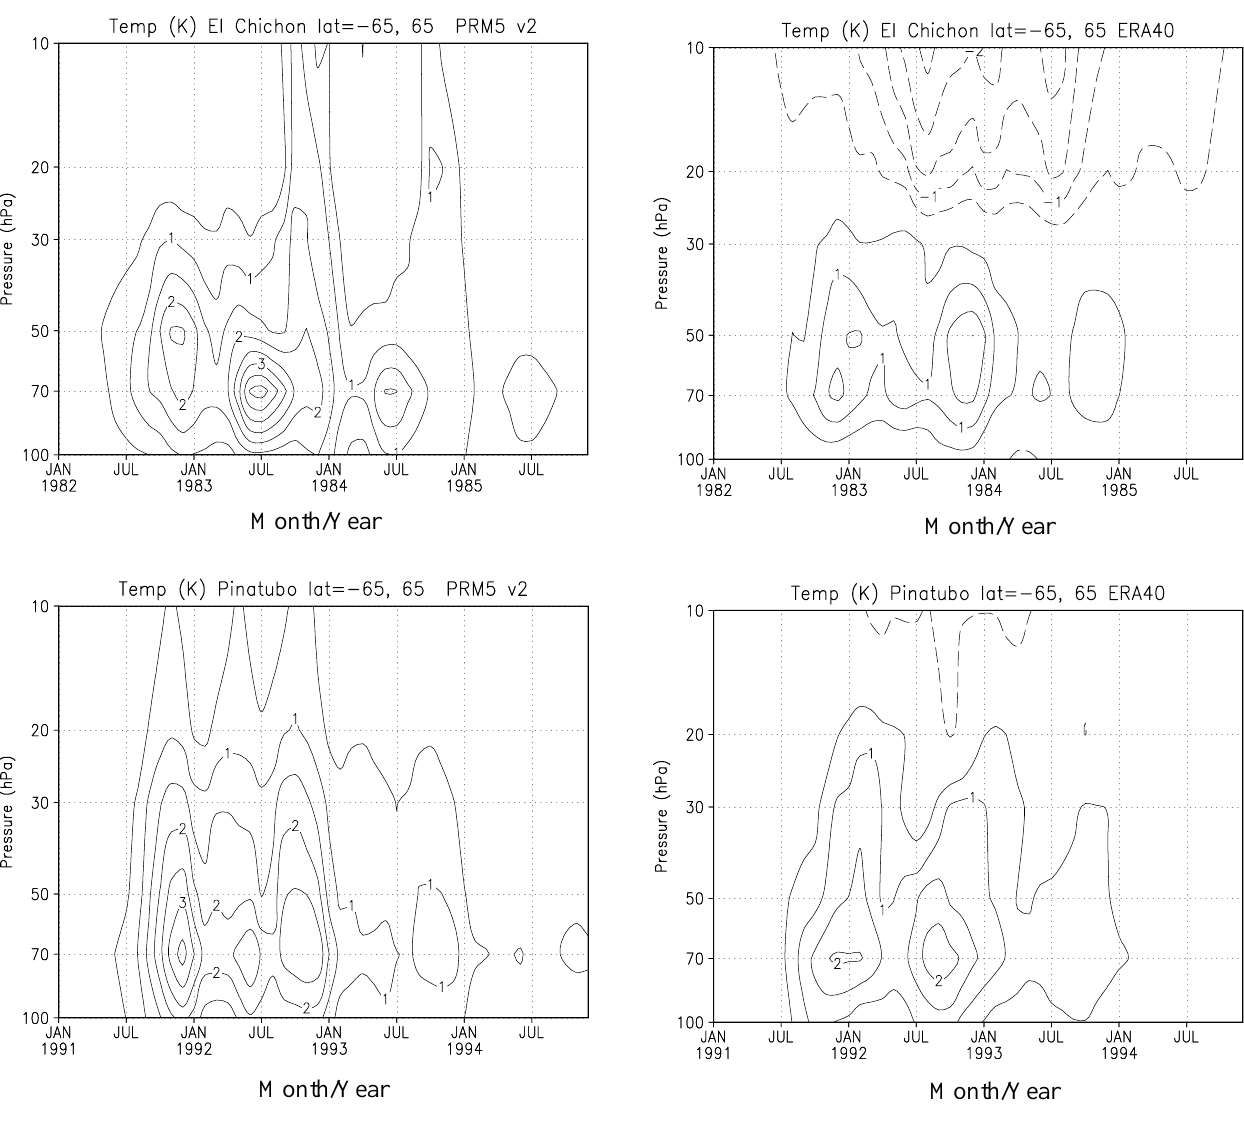
Fig. 18. Time-pressure cross sections of the global (65 ◦ S to 65 ◦ N) temperature after the El Chich´on eruption (upper) and Mount Pinatubo eruption (lower) for the simulation (left) and observation (ERA-40) (right). Contour interval is 0.5K and dashed contours denote negative values. Zero contours are omitted.